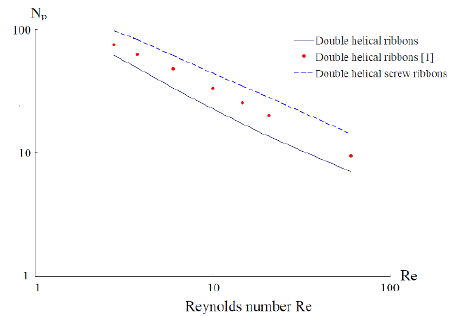
Figure 14. Pumping efficiency number variation E